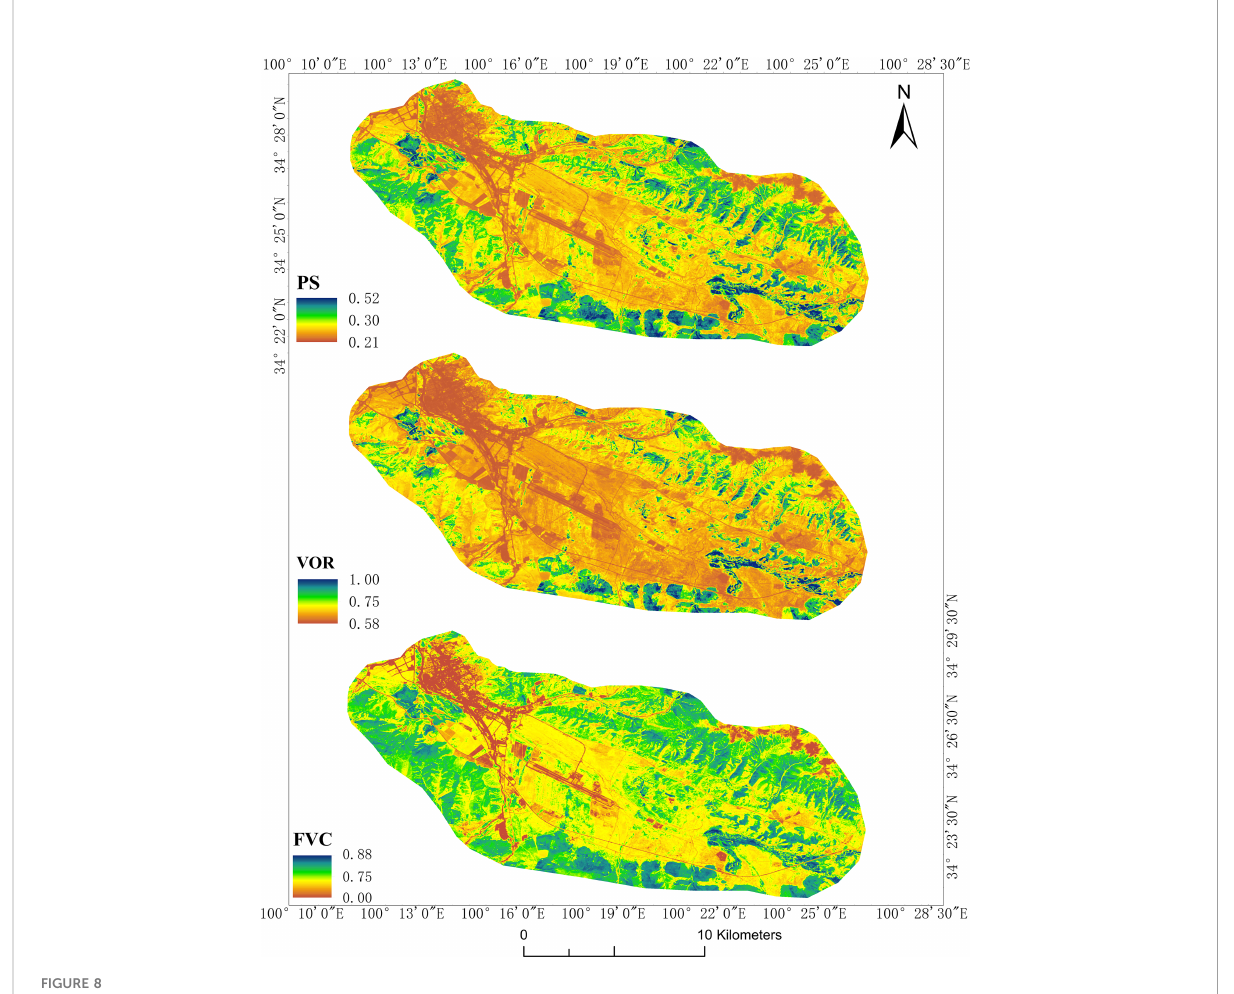
FIGURE 8 Spatial distribution of the PS, VOR, and FVC in Dangluo